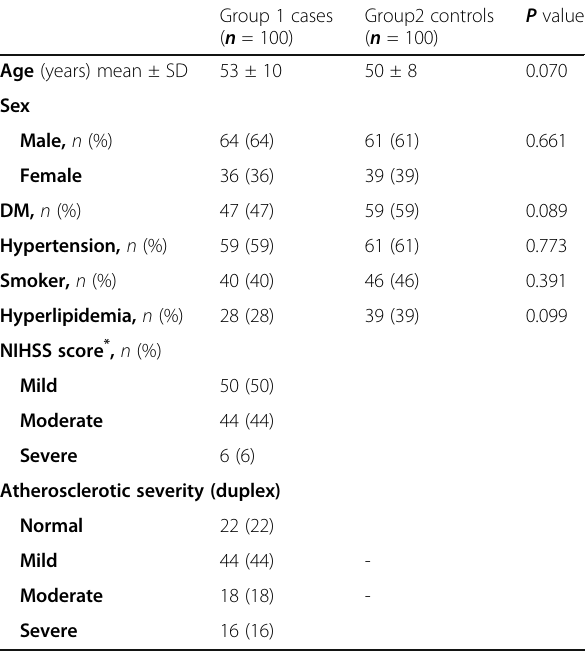
Table 1 Demographic data, associated co-morbidities, and risk factors of studied